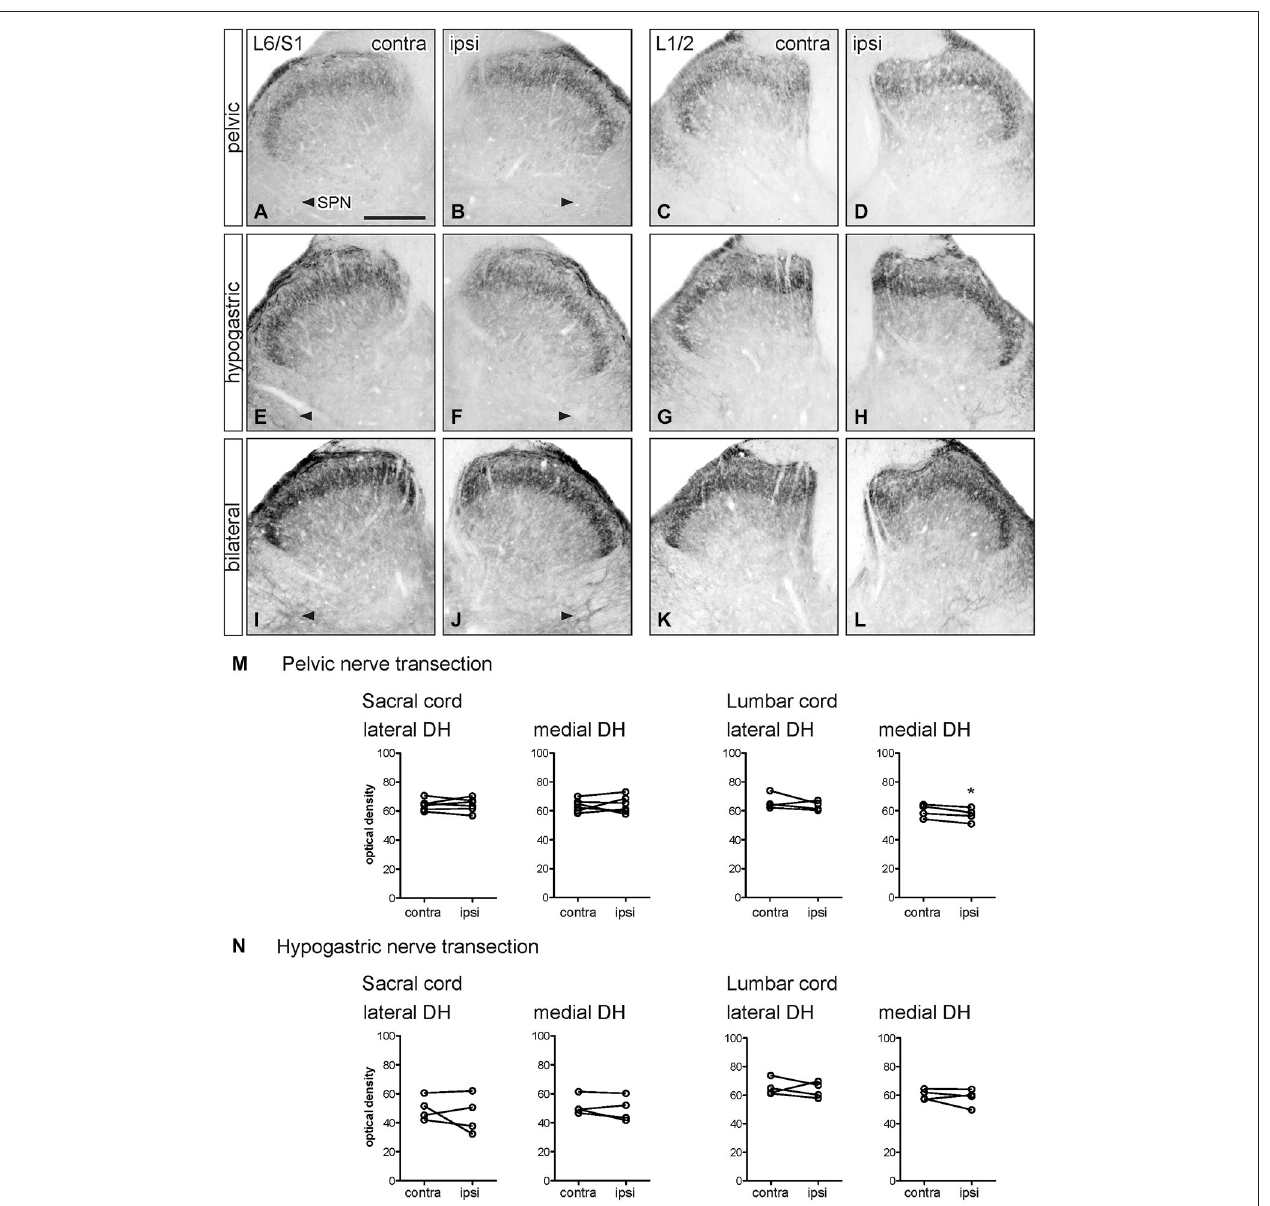
nerve transection, no change in GFR α 2-IR was seen in sacral dorsal horn. In lumbar spinal cord, there was a small but significant decrease in GFR α 2-IR only in the medial dorsal horn. (N) Unilateral hypogastric nerve transection had no effect on GFR α 2-IR in sacral or lumbar dorsal horn. Data represents the mean ± SEM ( n = 6 rats for sacral data following unilateral pelvic nerve transection, n = 4 rats for lumbar data following unilateral pelvic and hypogastric nerve transection) and was analyzed using a paired t -test. Scale bar represents 200 µ